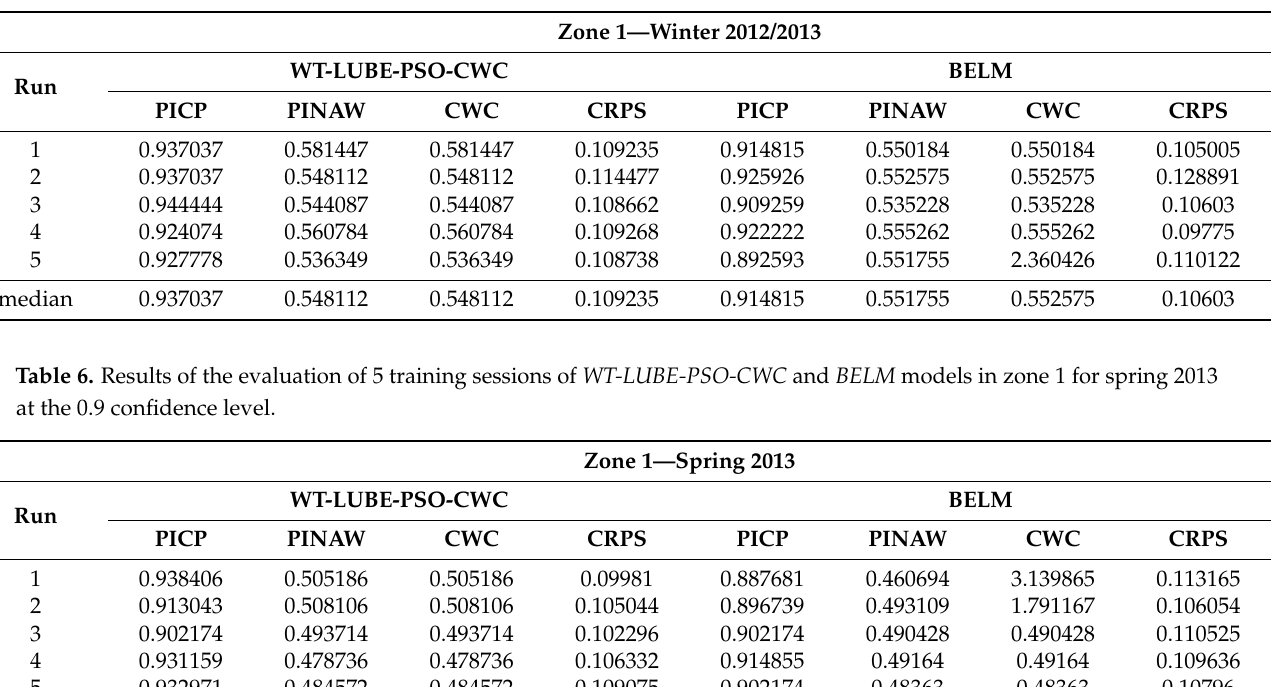
Table 5. Results of the evaluation of 5 training sessions of WT-LUBE-PSO-CWC and BELM models in zone 1 for winter 2012/2013 at the 0.9 confidence level.